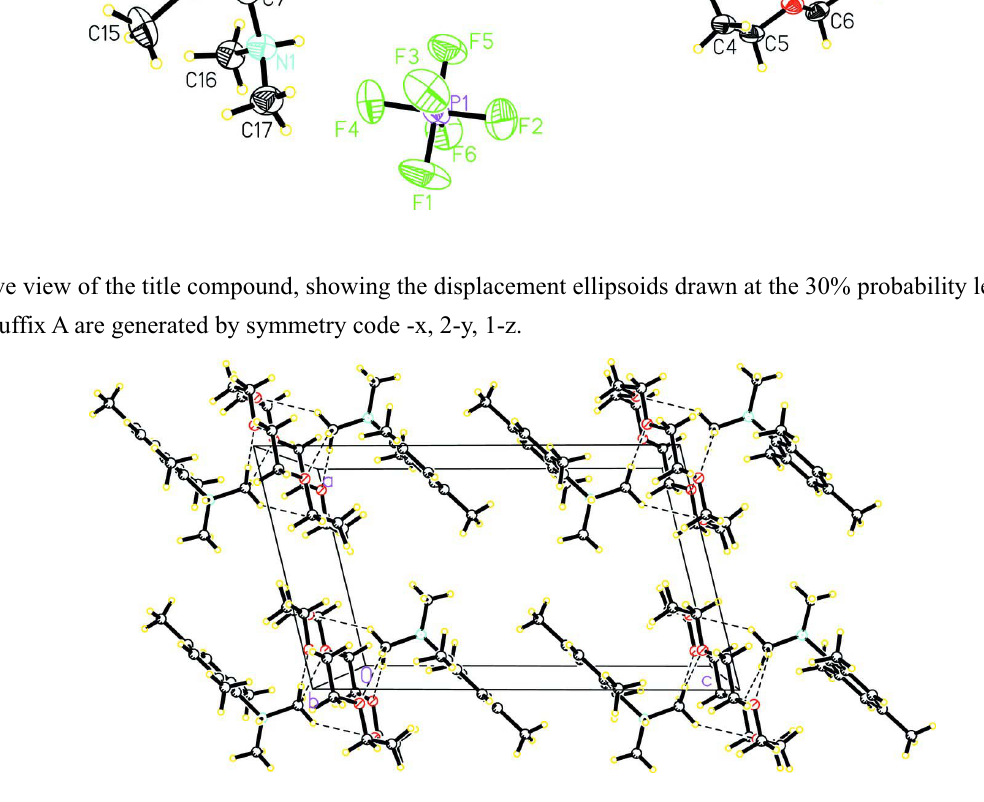
Figure 2 Crystal packing of the title compound viewed along the b axis, showing the hydrogen bonding network (dashed lines). N , N ,2,4,6-Pentamethylanilinium hexafluorophosphate–1,4,7,10,13,16-hexaoxacyclooctadecane